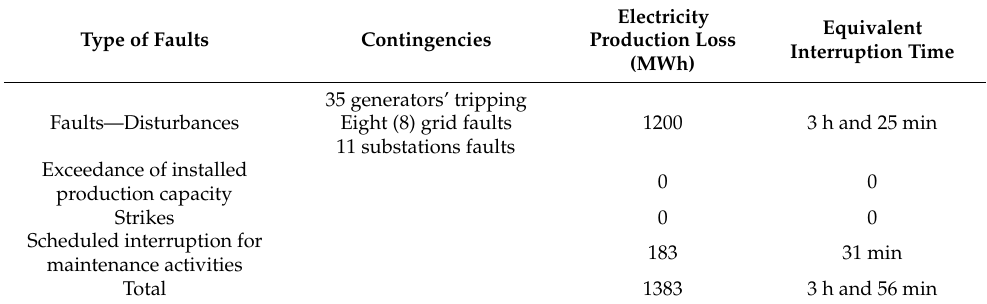
Table 3. Electricity production losses in Crete